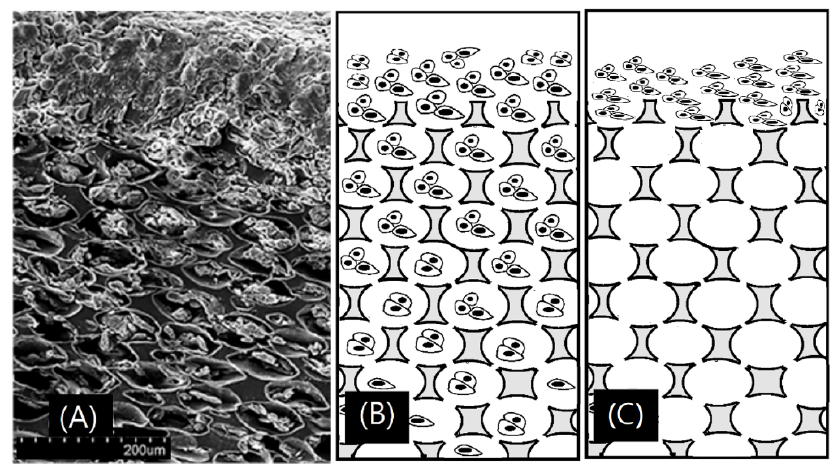
Figure 11. ( A ) SEM morphology of chondrocyte grown on EDC-crosslinked gelatin-based hydrogel scaffold after dynamic culture for 28 days(cross section) (scale bar = 200 μ m), ( B ) Schematic drawing of chondrocyte growth on EDC-crosslinked gelatin-based hydrogel scaffold after dynamic culture (cross section), and ( C ) Schematic drawing of chondrocyte growth on EDC-crosslinked gelatin-based hydrogel scaffold after static culture (cross section).